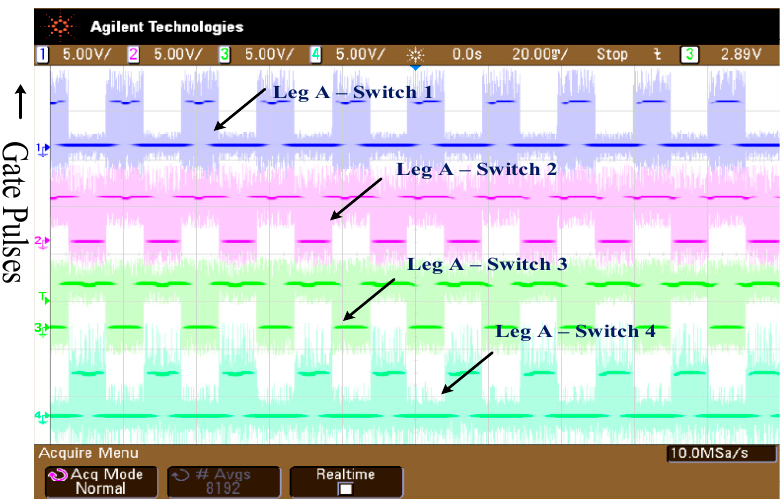
Figure 11. Excremental results of switching pulses of MCRSVPWM ‐ fed VSI for M a = 0.9.